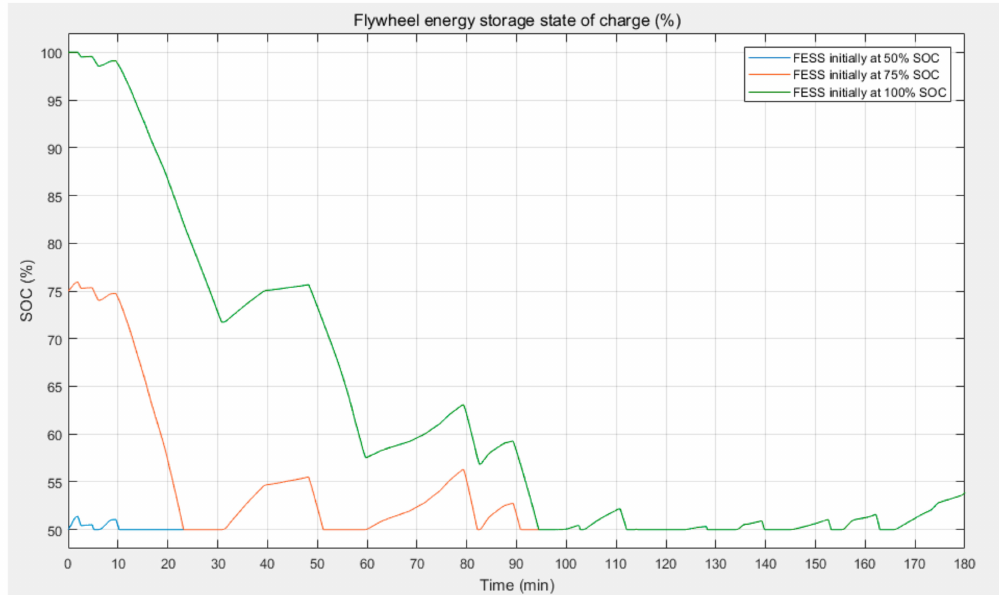
Figure 23. Flywheel charge-discharge plots at di ff erent states of charge.